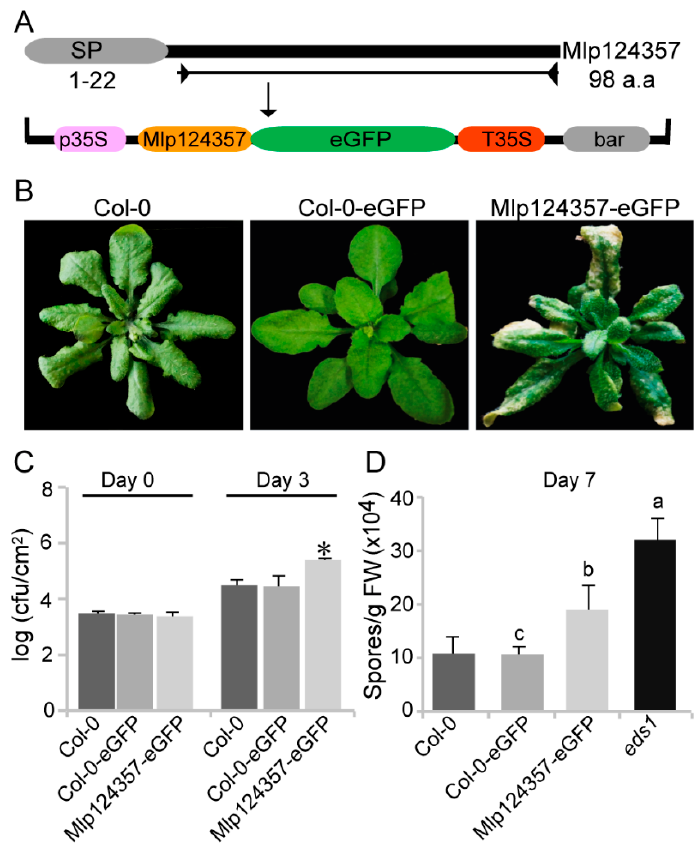
Figure 2. Mlp124357 expression in planta a ff ects the plant susceptibility to bacterial and oomycete pathogens. ( A ) Schematic representation of the T-DNA construct used for in planta expression of the Mlp124357 mature coding sequence. ( B ) Morphology of wild-type (Col-0) expressing eGFP or Mlp124357-eGFP. Photographs were taken from 4-week-old soil-grown plants. ( C ) Growth of PstDC3000 bacteria in Arabidopsis . Leaves of each genotype were infiltrated with a Pst DC3000 bacterial suspension (OD600 = 0.001) and the bacterial growth was measured on day 0 and day 3 after infection. Statistical significance was evaluated using a Student’s t-test ( p < 0.05); asterisk indicates a statistically significant di ff erence between plants carrying e ff ector and Col-0-GFP. Five replicates were used for each genotype; cfu, colony-forming unit. ( D ) Growth of H. arabidopsidis Noco2 in Arabidopsis . Each genotype was spray inoculated with H. arabidopsidis Noco2 spores (20,000 conidiospores / mL) and the number of conidiospores was quantified 7 days after inoculation. Statistical significance was evaluated using ANOVA ( p < 0.05) with Tukey’s test. Letters denote a significant di ff erence between Col-0-eGFP, Mlp124357eGFP, and eds1 . FW, fresh weight. Both bacterial and oomycete infection experiments were repeated at least three times and representative data are shown.